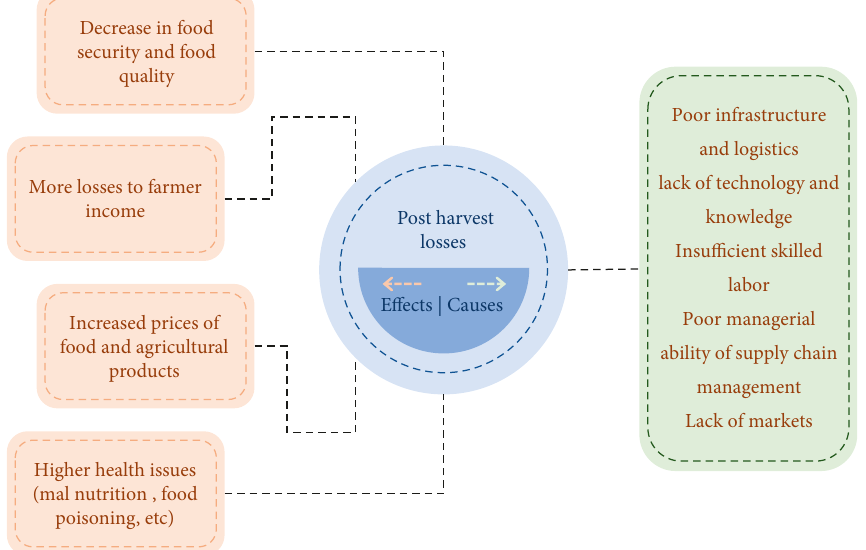
Figure 1: Causes and effects of postharvest losses on agricultural and food processing